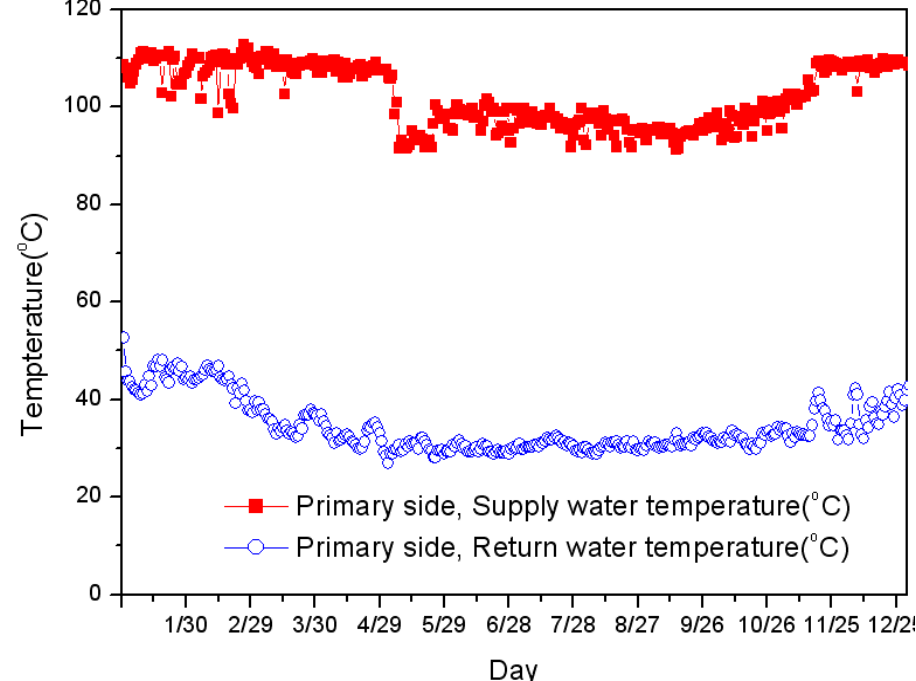
Figure 2. Annual variation of supply and return water temperatures of group energy primary side (supplier side) of the model apartment.